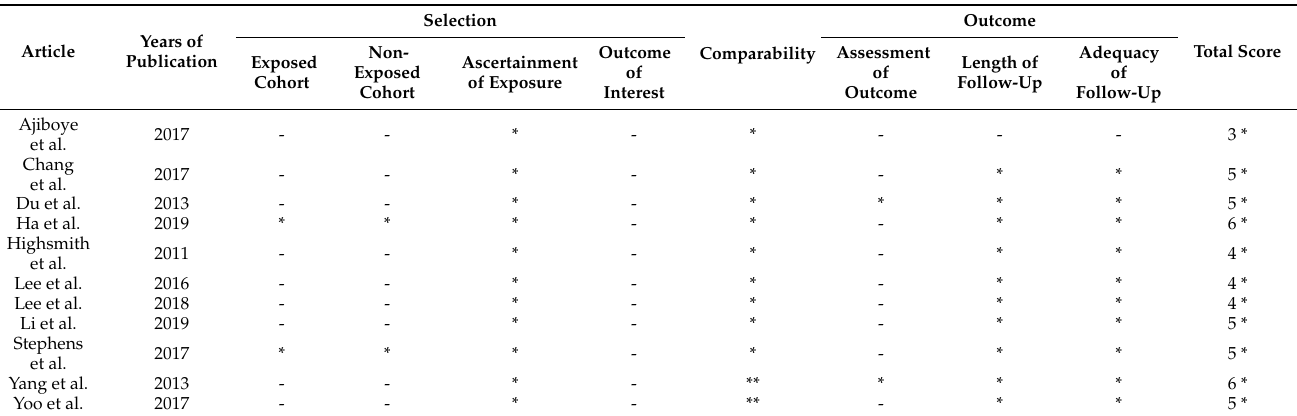
Table 1. Study Quality.